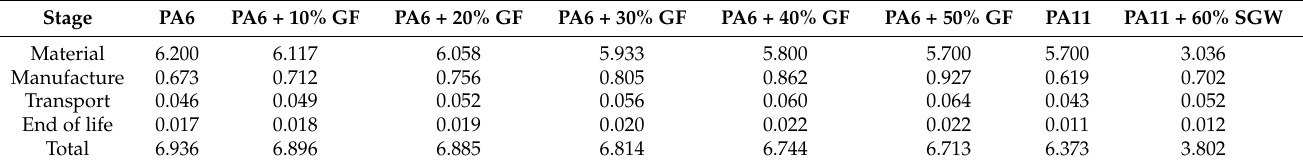
Table 5. Energy consumption (MJ) by LCA stage for various materials with a life expectancy of 10 years.